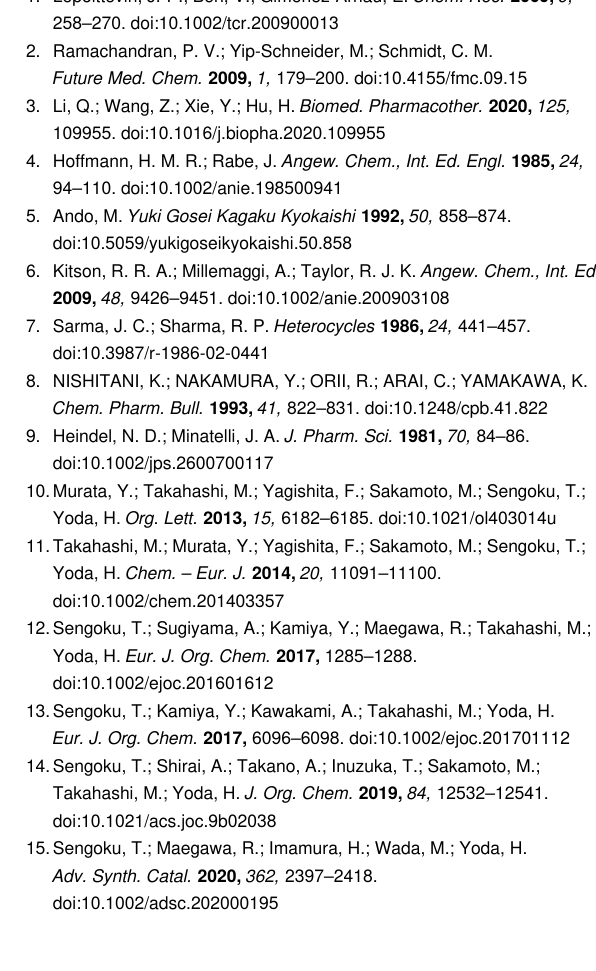
tams against P388 cells is simply related to the methylene lactone structure